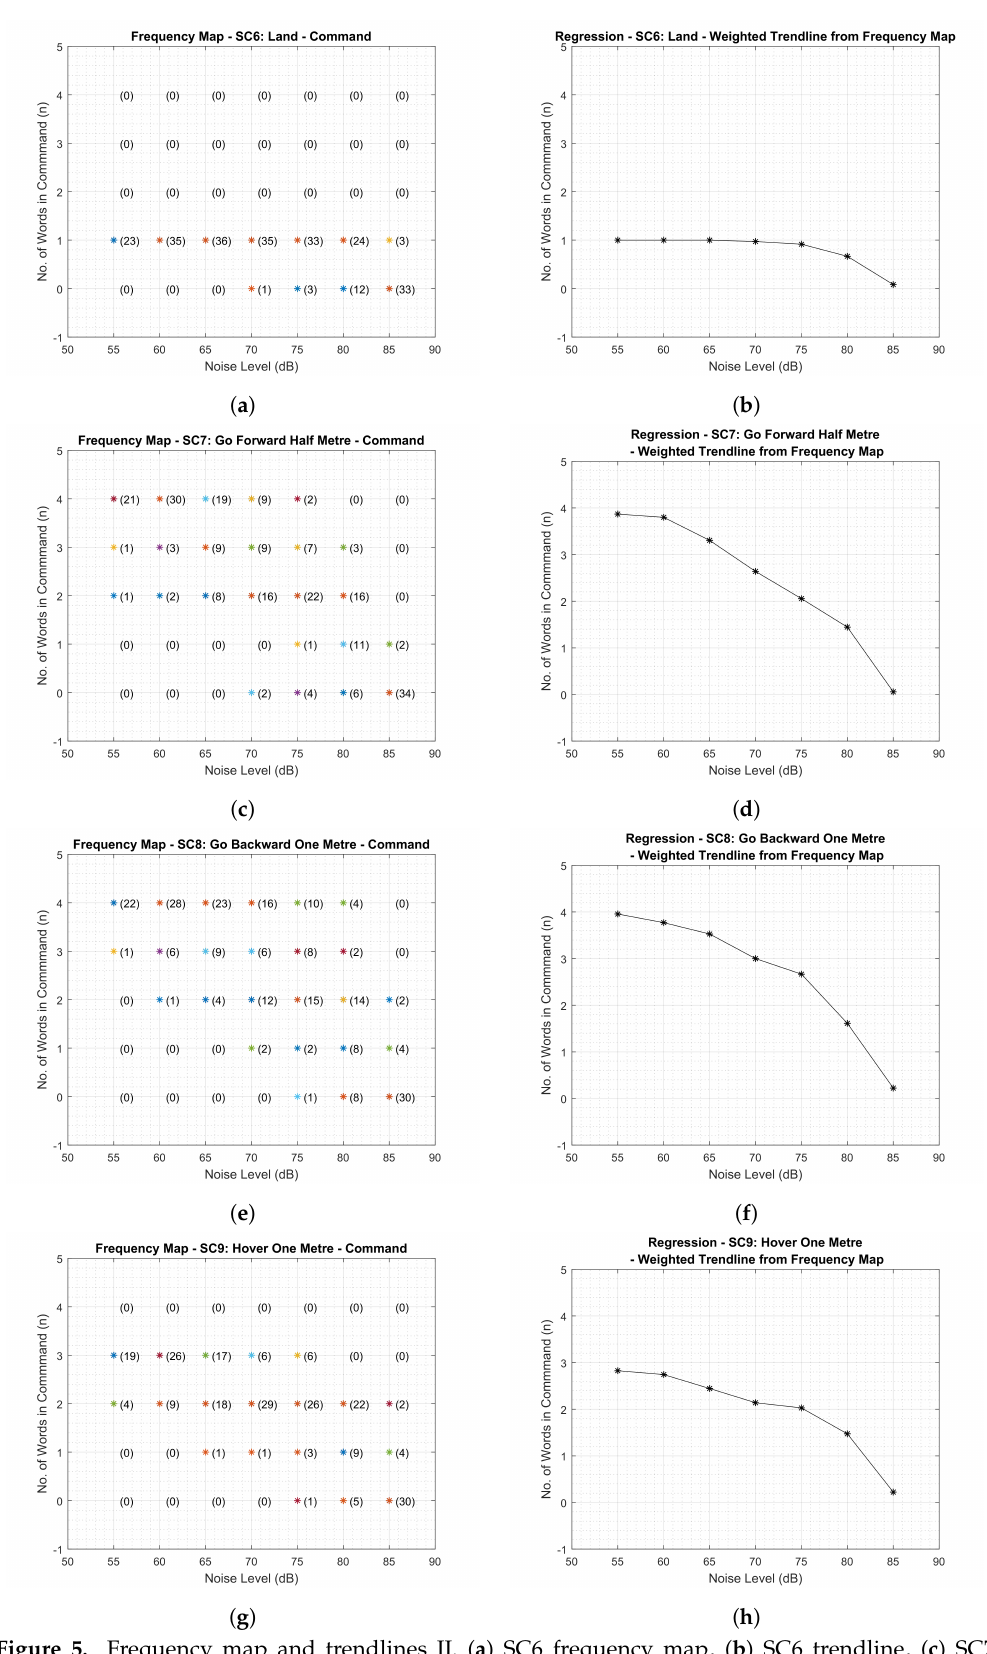
Figure 5. Frequency map and trendlines II. ( a ) SC6 frequency map, ( b ) SC6 trendline, ( c ) SC7 frequency map, ( d ) SC7 trendline, ( e ) SC8 frequency map, ( f ) SC8 trendline, ( g ) SC9 frequency map, ( h ) SC9